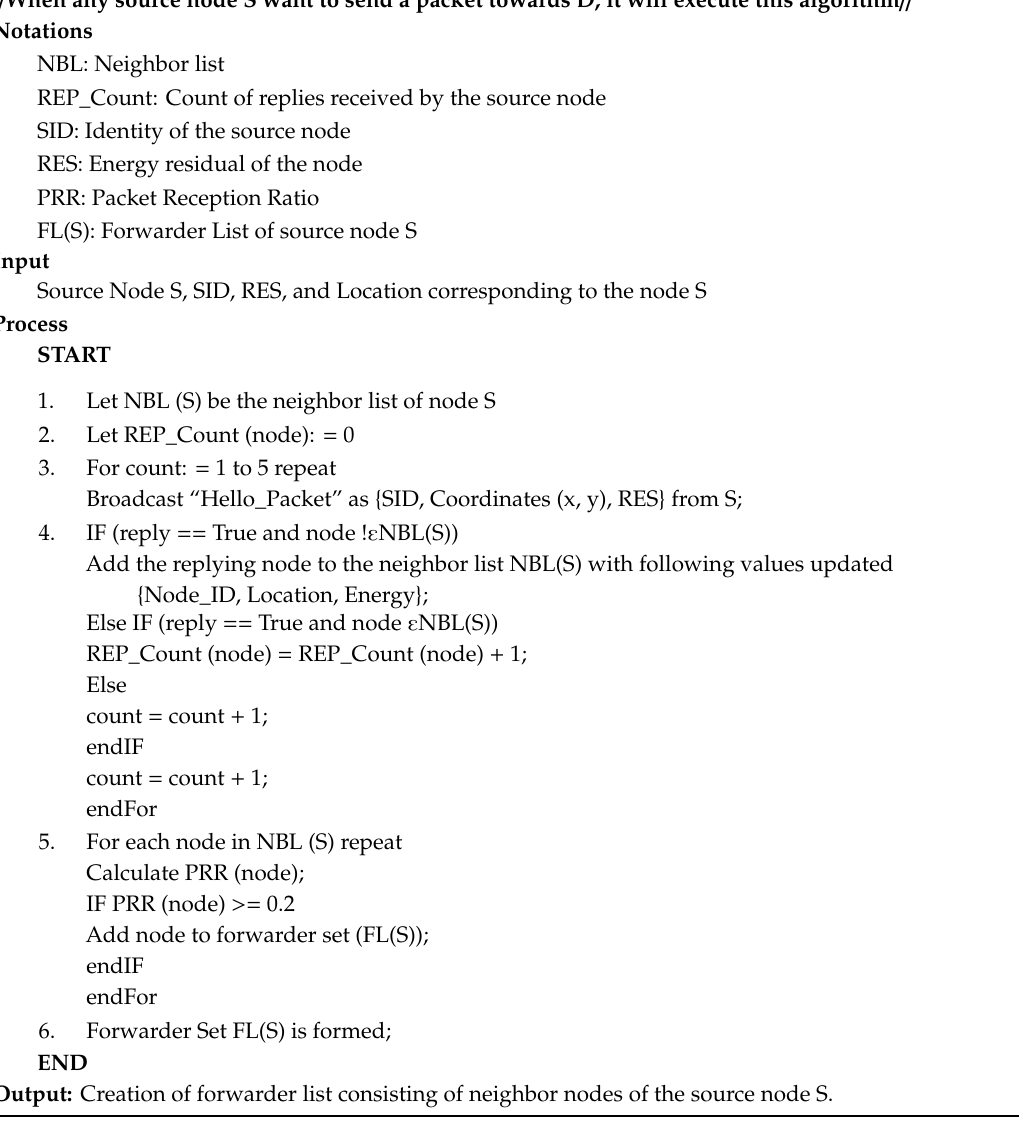
Algorithm 1. Forwarder_Set_Selection (S = Source, D = Destination) // When any source node S want to send a packet towards D, it will execute this algorithm //